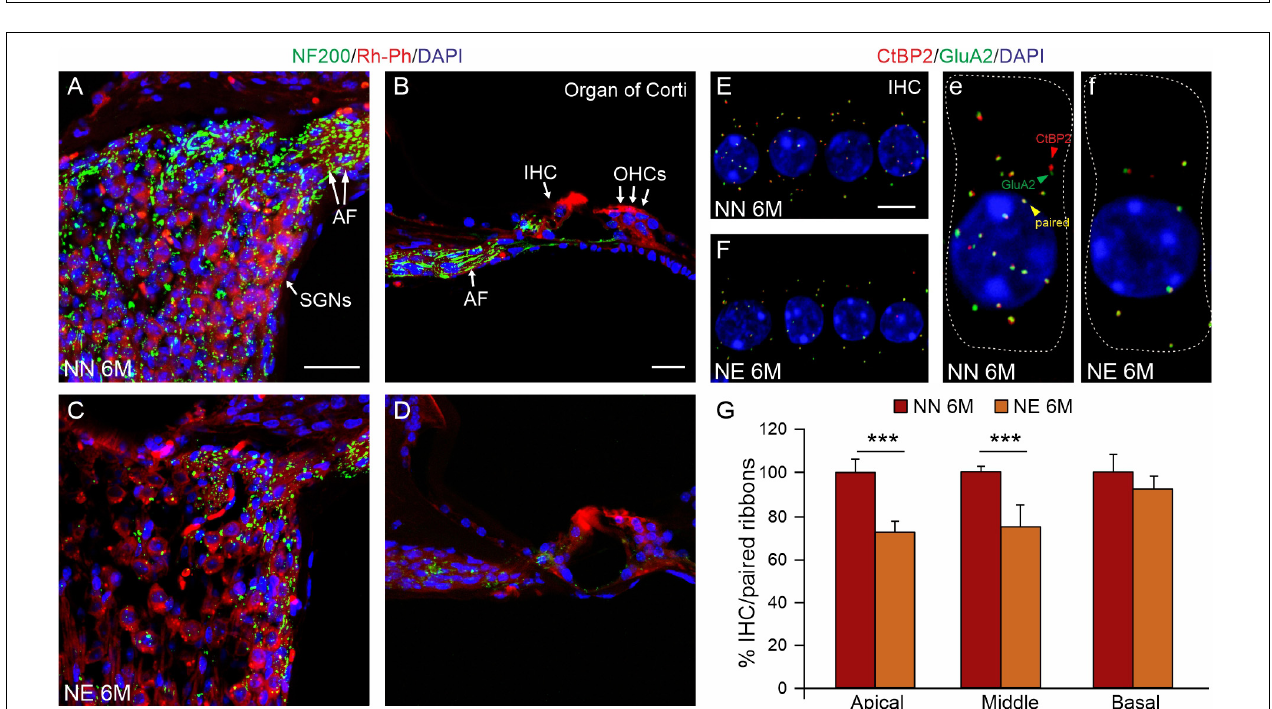
FIGURE 4 | Noise exacerbates age-related decrease of primary afferent fibers and synaptic ribbons. (A–D) Representative images showing primary afferent fibers (NF200, green fluorescence), Rh-Ph (red fluorescence) and DAPI staining (blue fluorescence) in cochlear cryosections (middle turn region) of no noise-exposed [NN group; (A,B) ] and noise-exposed [NE group; (C,D) ] animals of 6 months of age (M). A marked decrease of primary afferent fibers (AF) was observed in the Noise group compared with NN. (E,F) Representative images of surface preparations of the organ of Corti showing one row of inner hair cells stained for CtBP2 (red fluorescence, to label the synaptic ribbons, red arrows) and anti-GluA2 (green fluorescence, to visualize postsynaptic puncta, green arrows) and double stained with DAPI. Paired puncta are indicated by yellow (red + green) labeling (yellow puncta). High magnifications of a single hair cell (outlines of selected hair cells are indicated by dashed lines) are shown in panels (e,f) . (G) Histogram (means ± SEM) shows the percentage of paired synapses/IHC, normalized to NN 6 M values, in cochlear turns. Note that no significant differences between NE and NN mice were observed in basal cochlear region (affected already by aging) but significant differences were observed in middle and high cochlear region, indicating a worsened/accelerated aging effect by noise. Asterisks indicate significant differences between groups (*** p < 0.001) from Student’s t -test. Scale bar (A,D) 20 µ m; (E,F) 8 µ